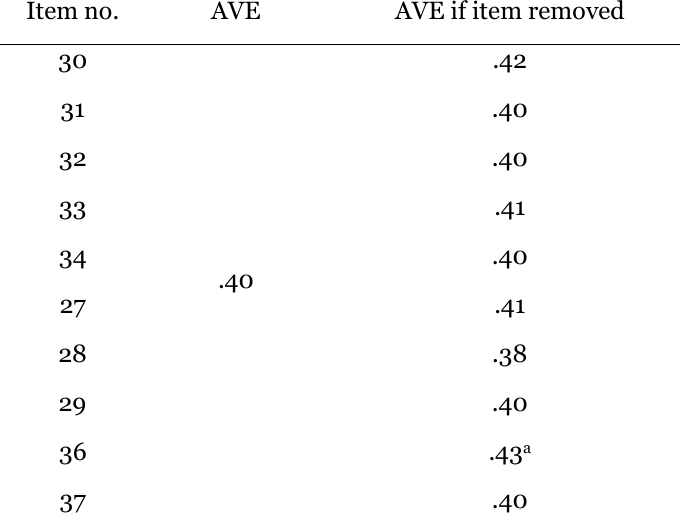
AVE Reliability for Factor 12 Item no. AVE AVE if item